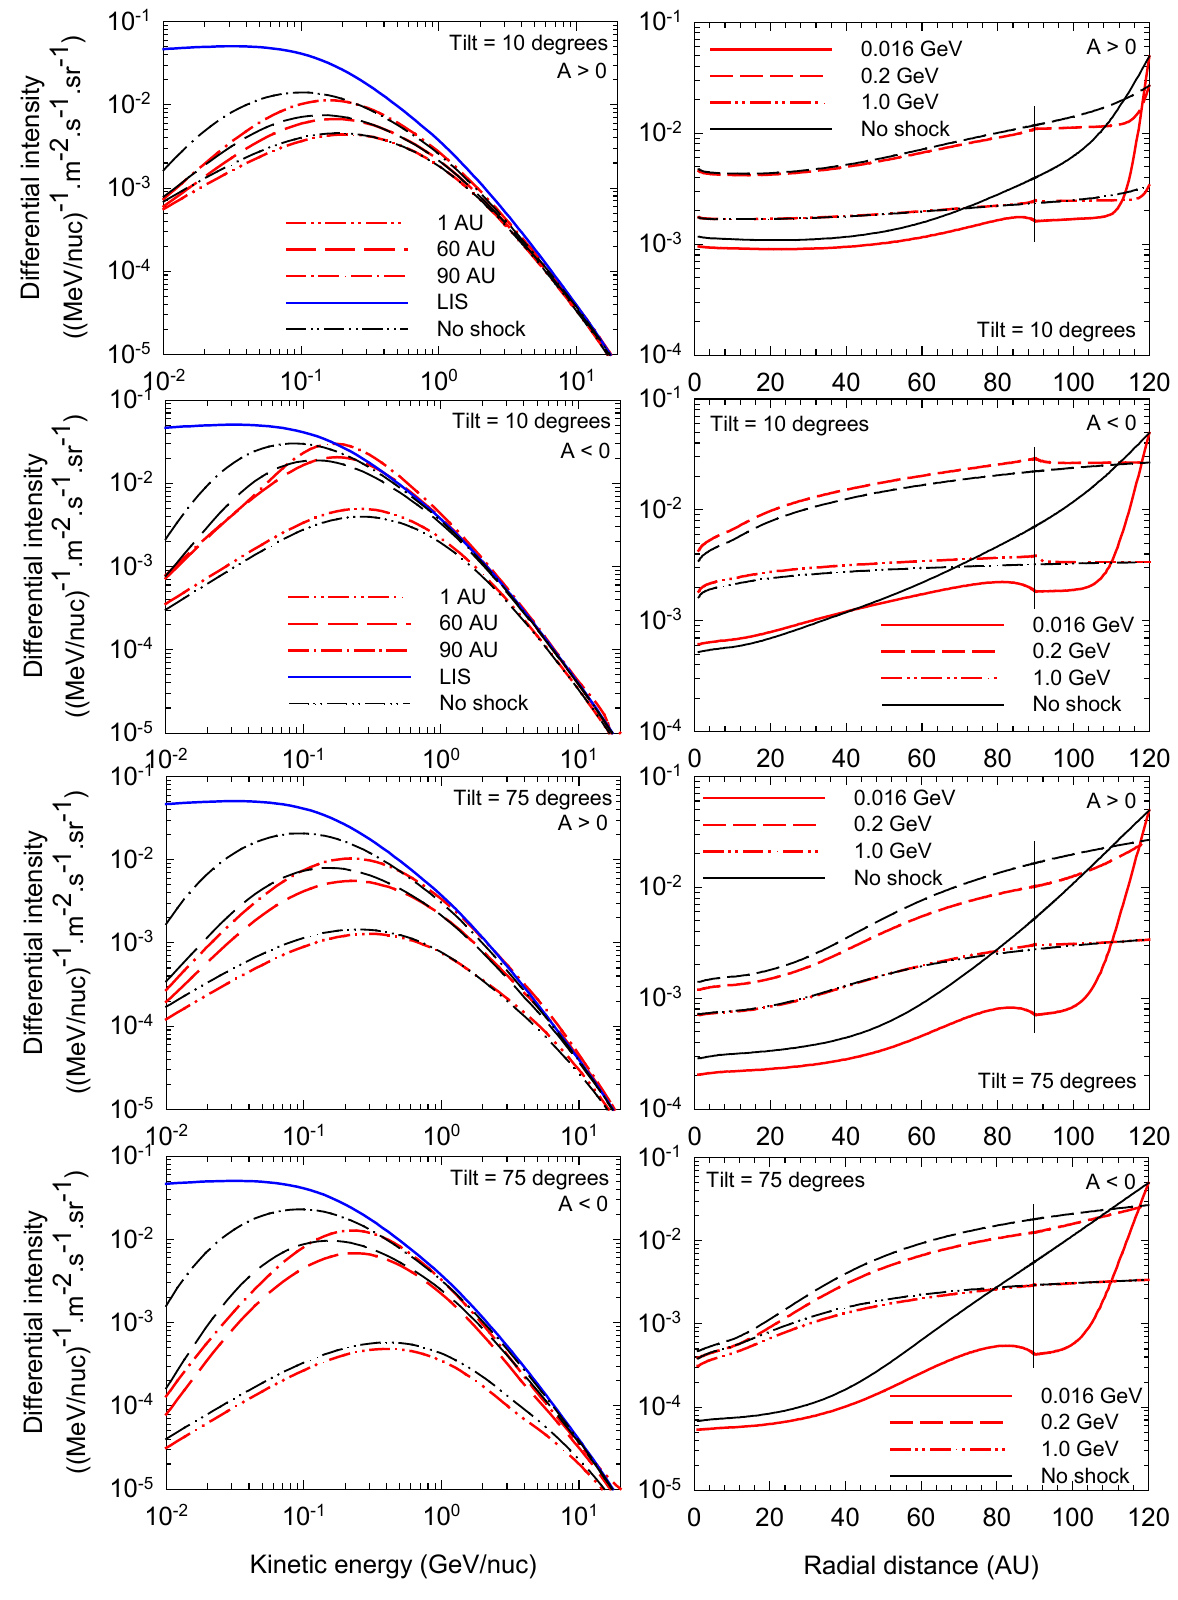
Fig. 2. Similar to Figure 1 but for carbon (C).